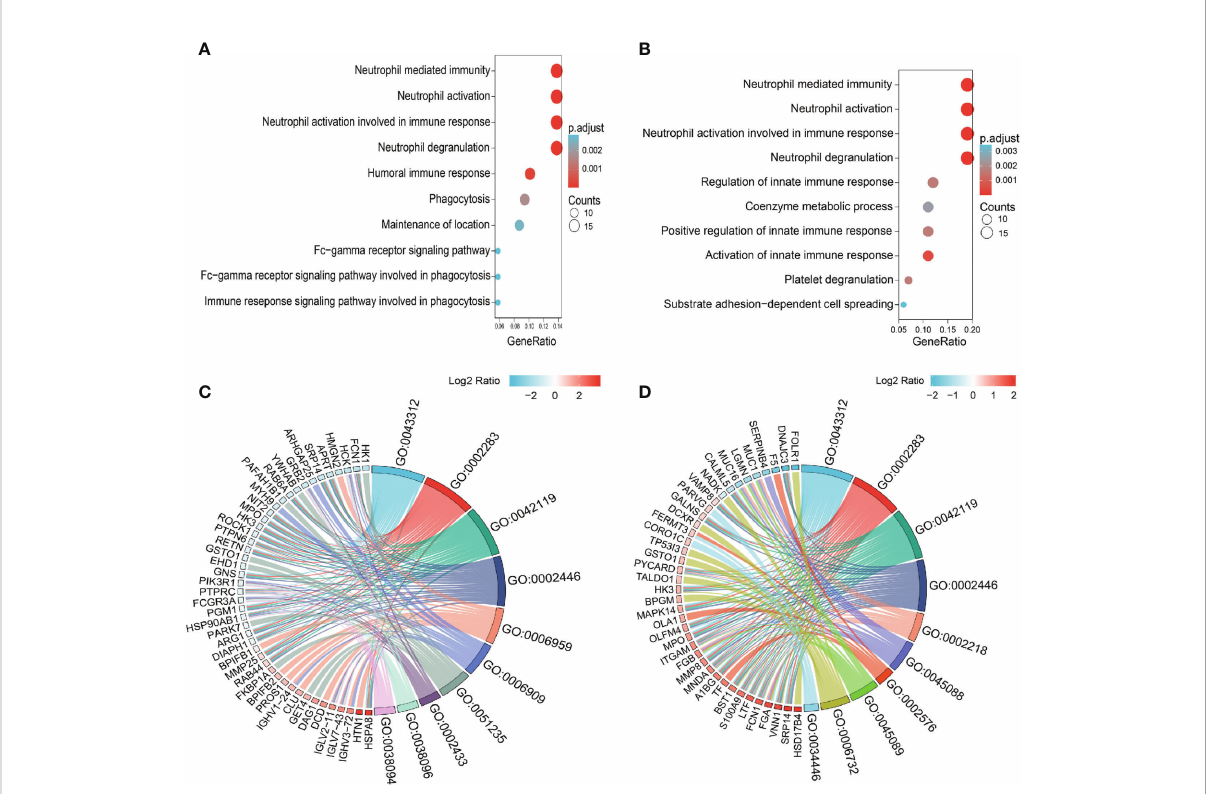
FIGURE 3 Enriched GO categories of DEPs in the comparison between IgG4-RD with four subgroups in saliva. (A) Enriched GO categories of DEPs in the comparison between Mikulicz group vs. Retroperitoneal aorta group. (B) Enriched GO categories of DEPs in the comparison between Head and neck group vs. Retroperitoneal aorta group. (C) Chordal diagram of GO categories in comparison between Mikulicz group vs. Retroperitoneal aorta group. (D) Chordal diagram of GO categories in the comparison between Head and neck group vs. Retroperitoneal aorta group. The left half part is the gene color block and different color represents the corresponding gene Log2 Ratio values, the right half is the GO category color block, and the size of the color block represents the corresponding